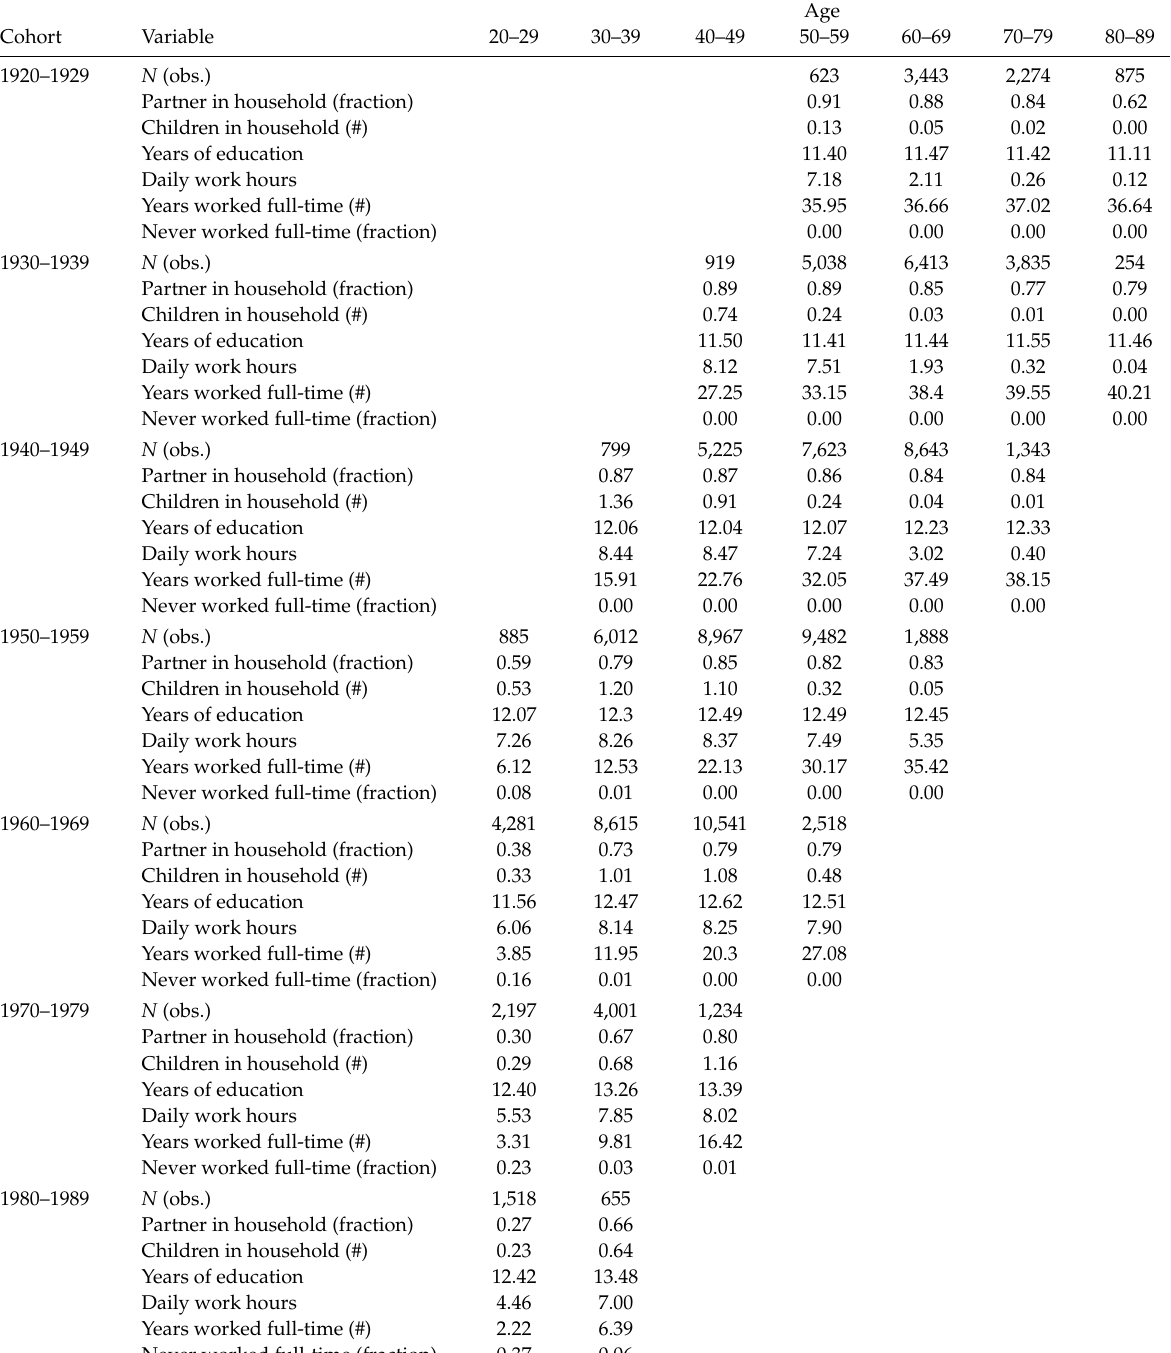
Table 2: Descriptive statistics